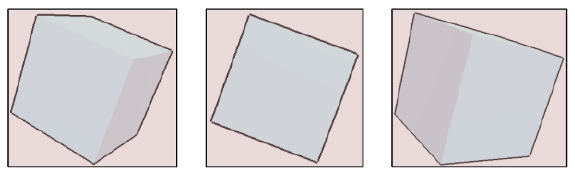
Figure 7: 2D bounding boxes created around a synthetic 3D bounding box. The same 3D box is used in each image, with only the camera perspective changing between images.